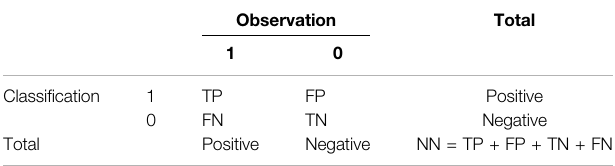
TABLE 2 | Confusion matrix.